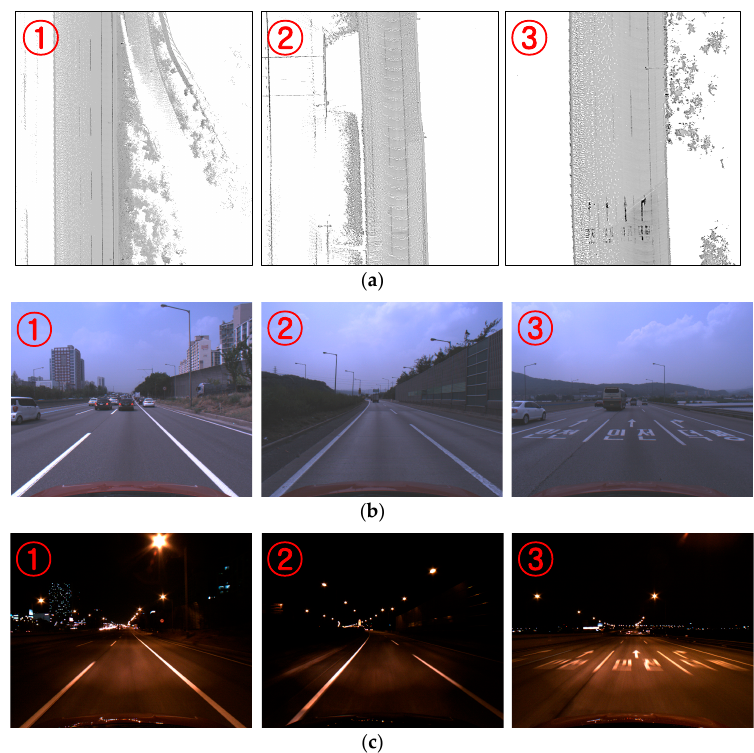
Figure 10. Highway the vehicle drove when acquiring the test dataset. ( a ) 3D points at three sample locations; ( b ) Images taken in daytime; ( c ) Images taken at nighttime.